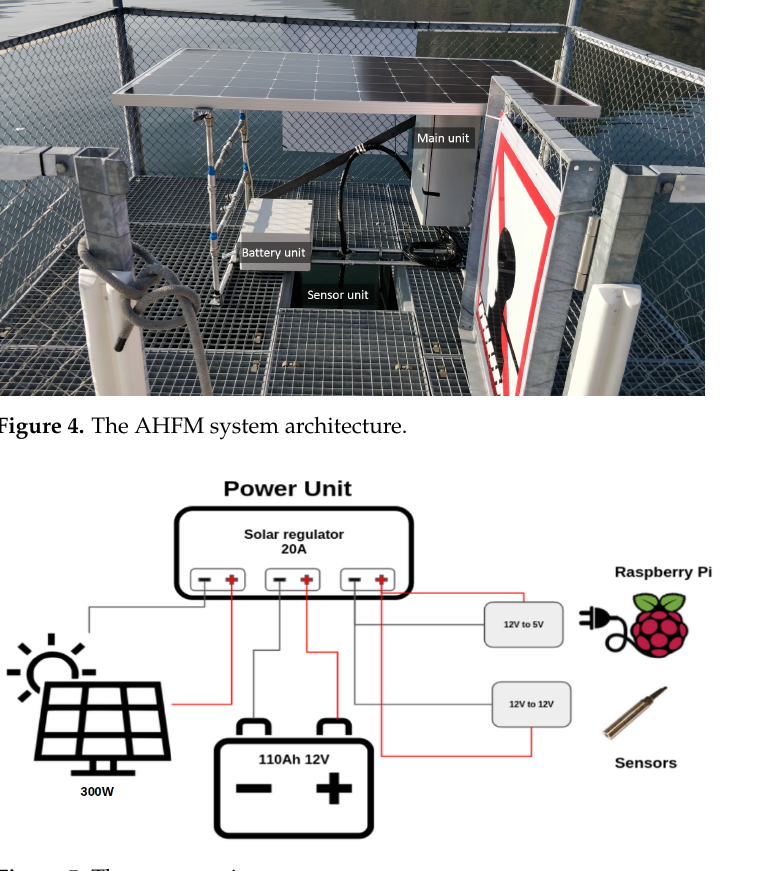
Figure 5. The power